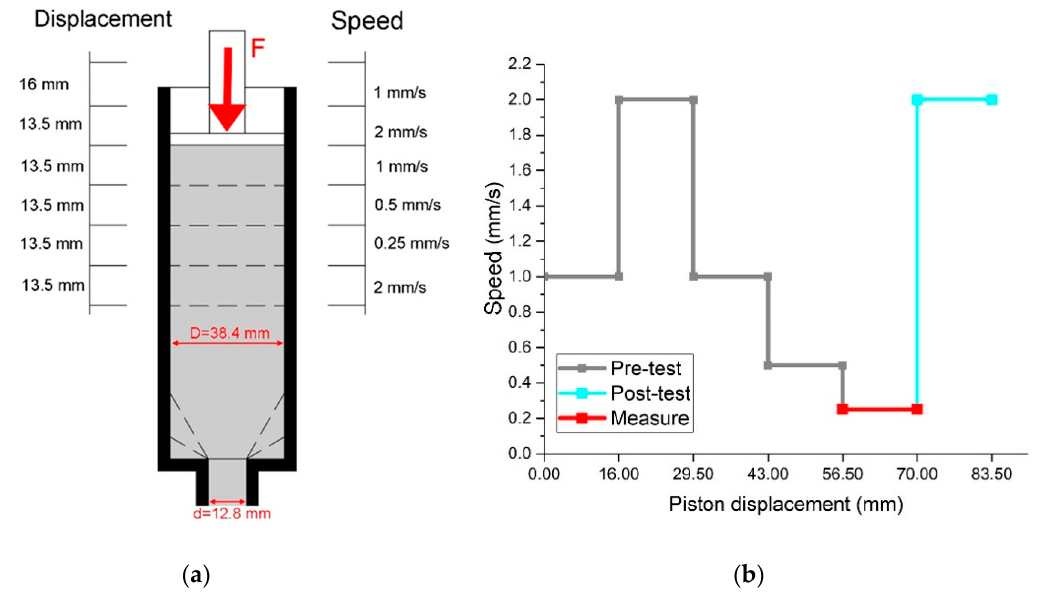
Figure 2. ( a ) Section drawing of the ram extruder; ( b ) Photograph of the ram extruder.